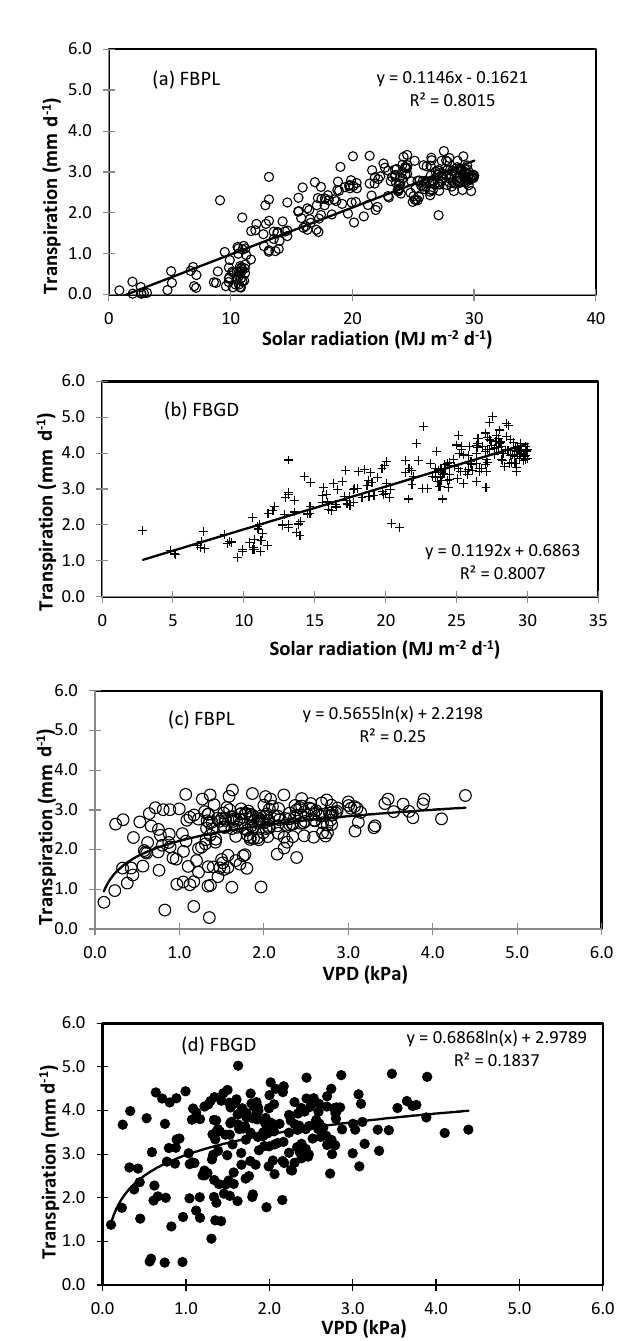
Figure 3. Transpiration response of full-bearing (a) “Cripps’ Pink” to solar radiation, (b) “Golden Delicious” to solar radiation, (c) “Cripps’ Pink” to VPD (d) “Golden Delicious” to